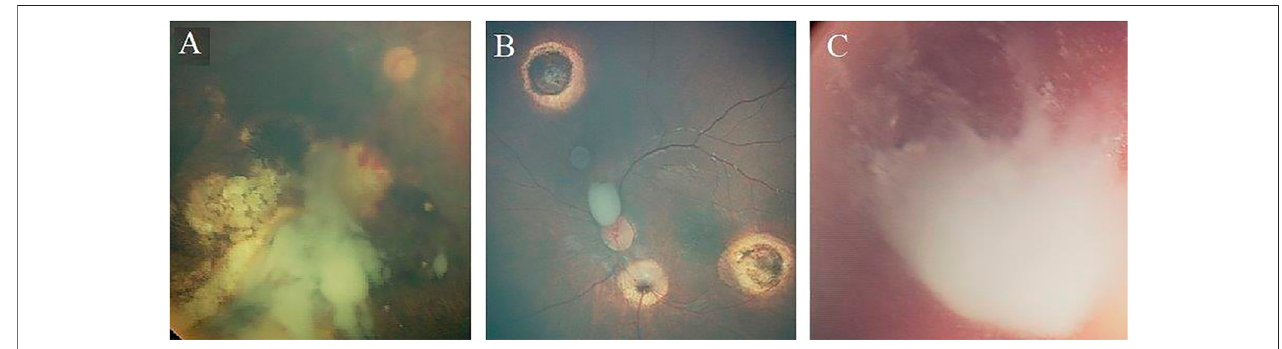
FIGURE1 | MorphologictypesofrecurrentandrefractoryvitreousseedsinRbpatients. (A) Eyethatharbouresmassivecloud(typeIIIvitreousseeds). (B) Eyethat harbours mixture of 2 types of vitreous seeds; sphere (type II vitreous seeds), and cloud (type III vitreous seeds). (C) Large cloud (type III vitreous seeds) associated with massive Dust (type I vitreous seeds)..